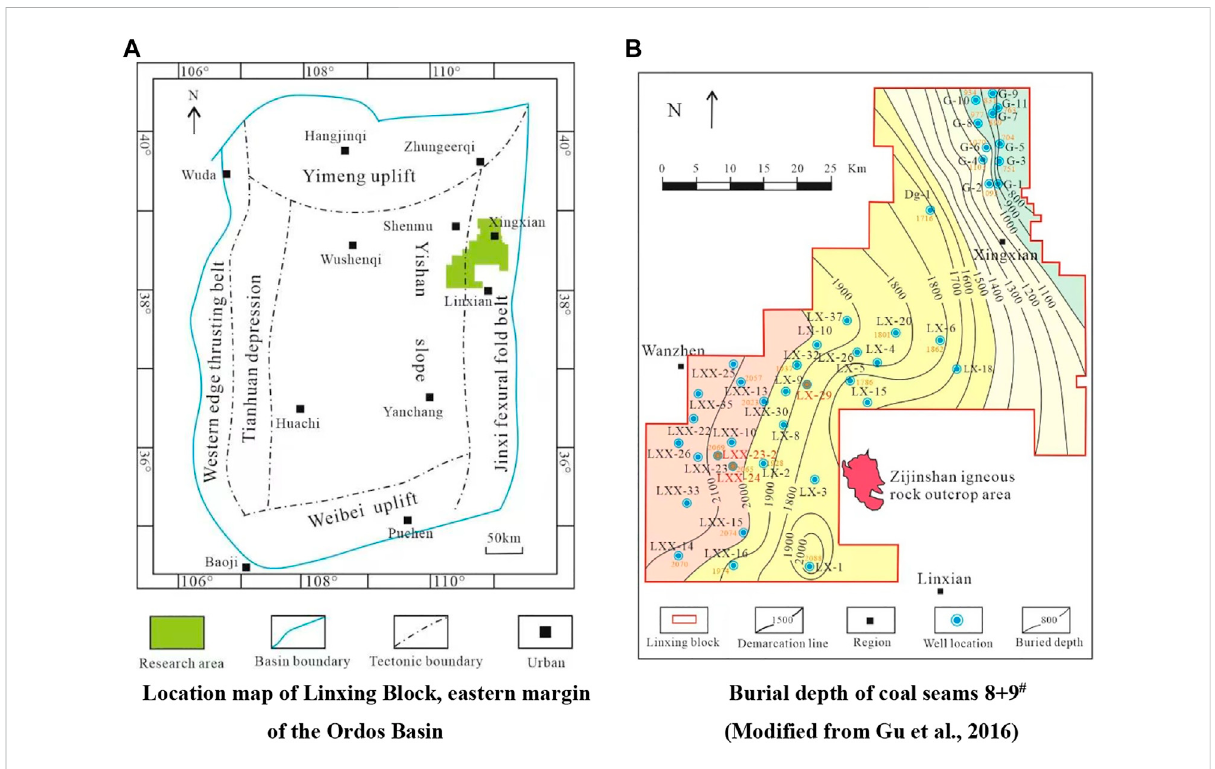
FIGURE 1 Location map (A) , burial depth of coal seams 8+9 # (B) in Linxing